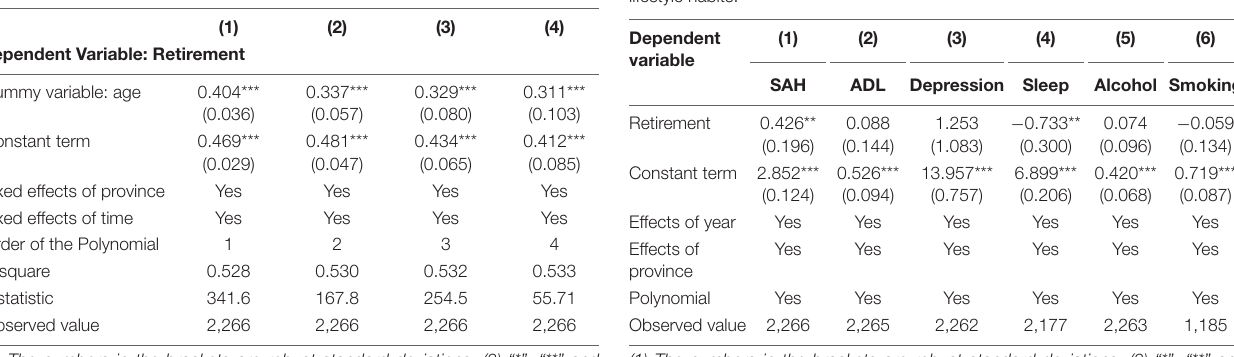
TABLE 3 | The first-stage regression: effects of the retirement policy on the retirement rate.